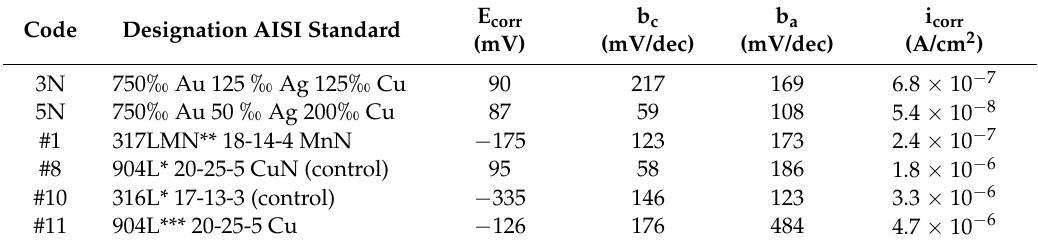
Table 8. Electrochemical parameters calculated for the different grades of steel and gold alloys in the Tafel domain.